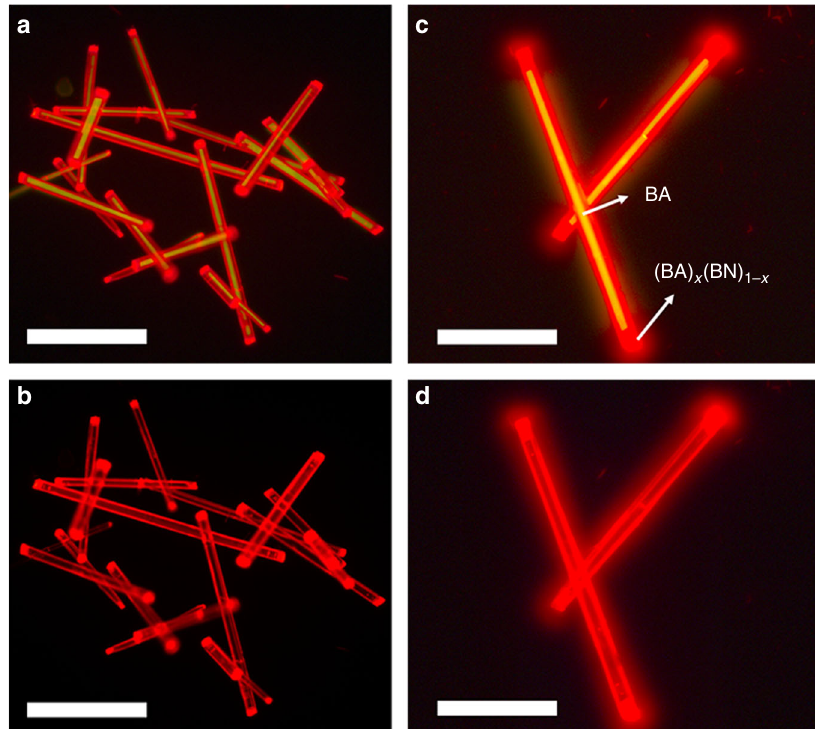
Fig. 7 Optical characterization of BA@(BA) x (BN) 1- x core-shell structures. a – d Upon excitation with ( a , c ) blue and ( b , d ) green light, fl uorescence microscopy images of BA@(BA) x (BN) 1- x core-shell structures obtained by mixing BA tubes with 2 mL of a saturated supernatant of (BA) 0.72 (BN) 0.28 alloy helices at ( a , b ) low and ( c , d ) high magni fi cation. Scale bars, 50 μ m in a , b , and 25 μ m in c ,